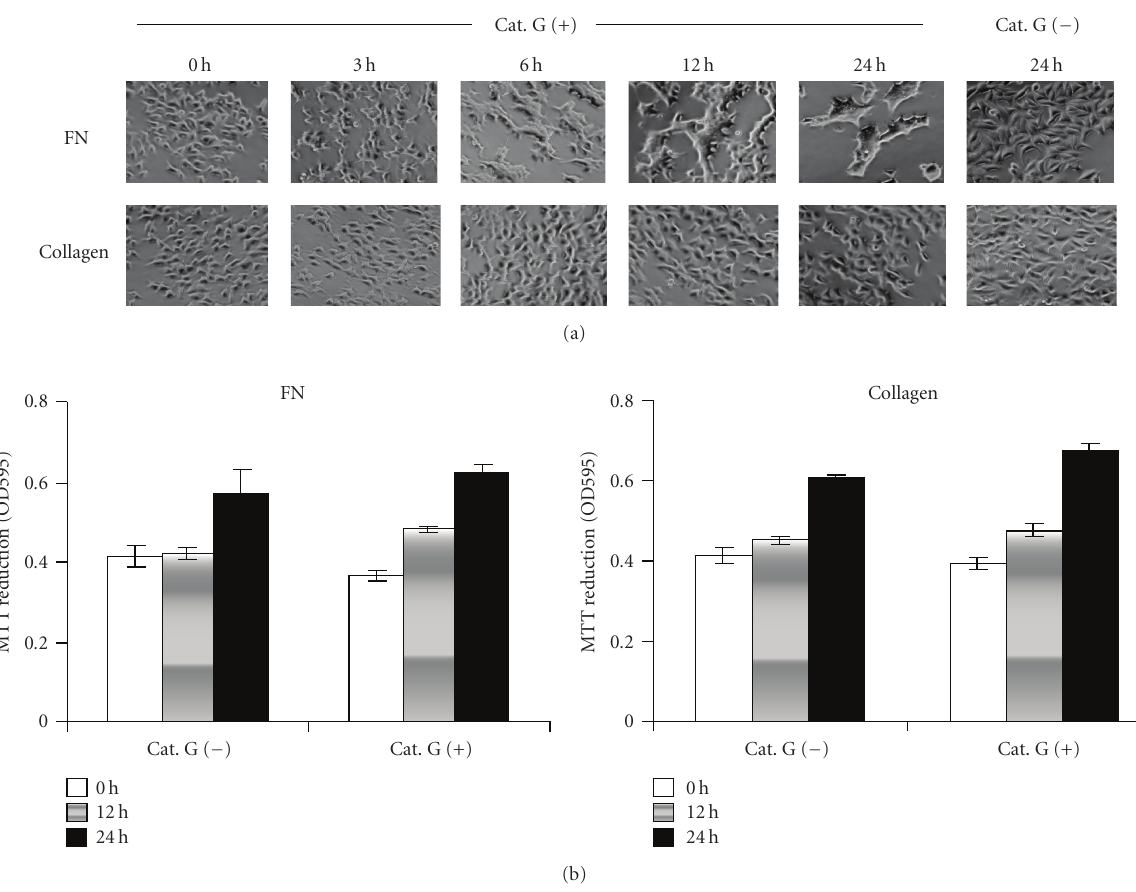
Figure 2: Cathepsin G induces cell condensation in MCF-7 cells on fibronectin, but not on type IV collagen. 1 × 10 5 MCF-7 cells were cultured in dishes coated with fibronectin or type IV collagen for 24 hours. After washing, adherent cells were incubated in serum-free medium without or with 0.5 mU/mL cathepsin G. (a) Cathepsin G-induced cell condensation of MCF-7 cells was analyzed by phase-contrast microscopy in the indicated periods as described in Materials and Methods. (b) MTT-reducing activity was measured at the indicated times. Bars represent the standard deviation. Analyses were performed in triplicate in duplicate